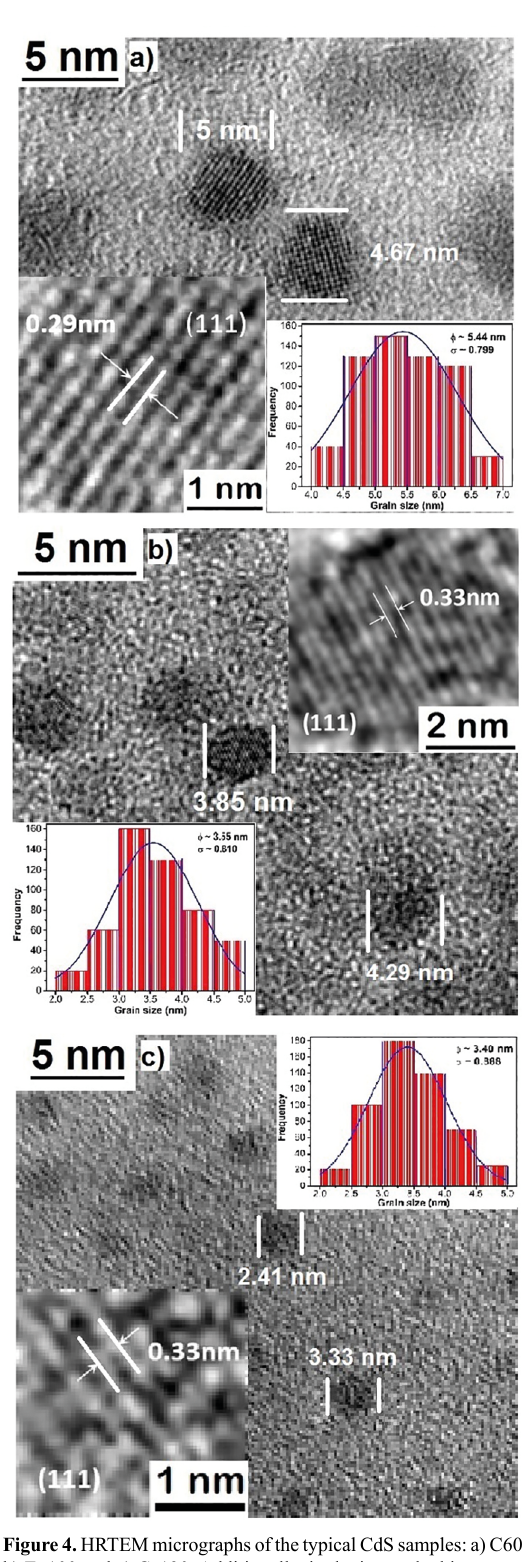
Figure 4. HRTEM micrographs of the typical CdS samples: a) C60, b) Eu100 and c) Ce130. Additionally, in the insets the